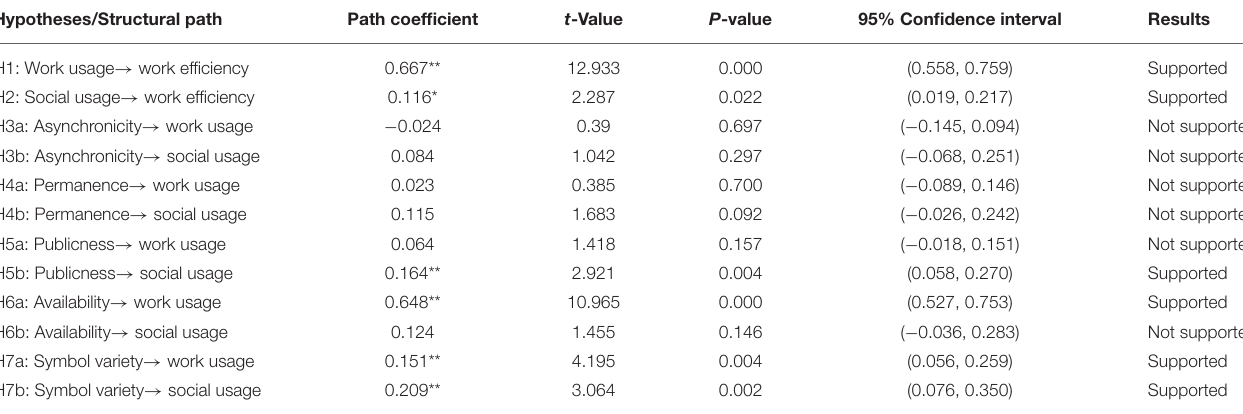
TABLE 4 | Hypotheses